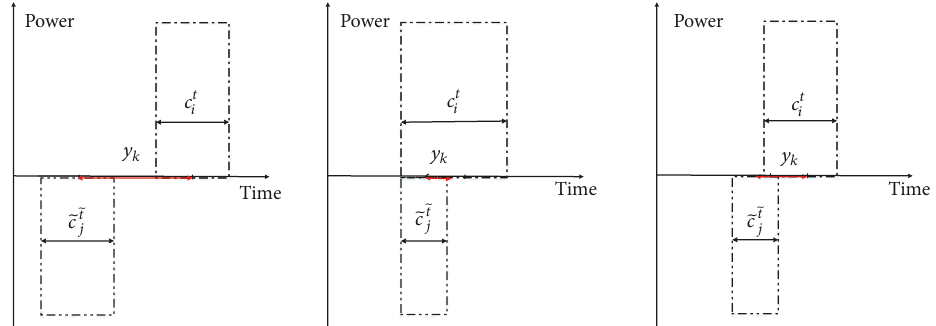
Figure 4: Three cases for net energy consumption